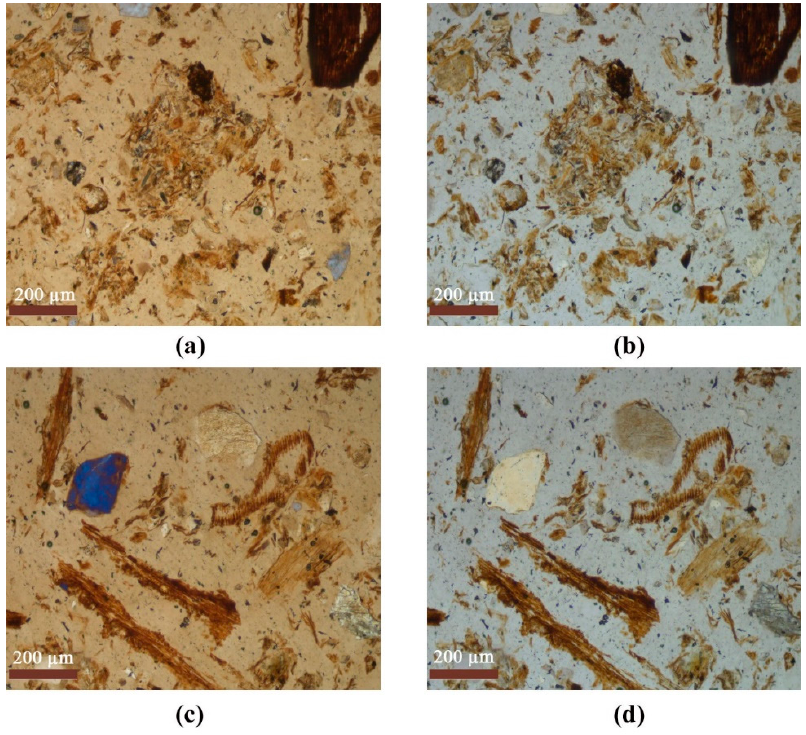
Figure 10. Biogenic aggregates ( a , b ) and tissues ( c , d ). S 3 (16–25 cm). ( a , c ) Plane polarized light; ( b , d ) crossed polarized light.